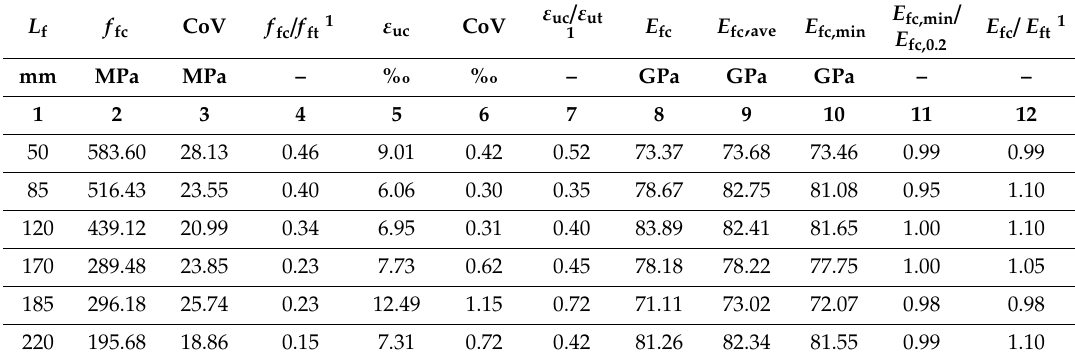
Table 2. Comparison of compression and tension characteristics of HFRP bars (absolute value).